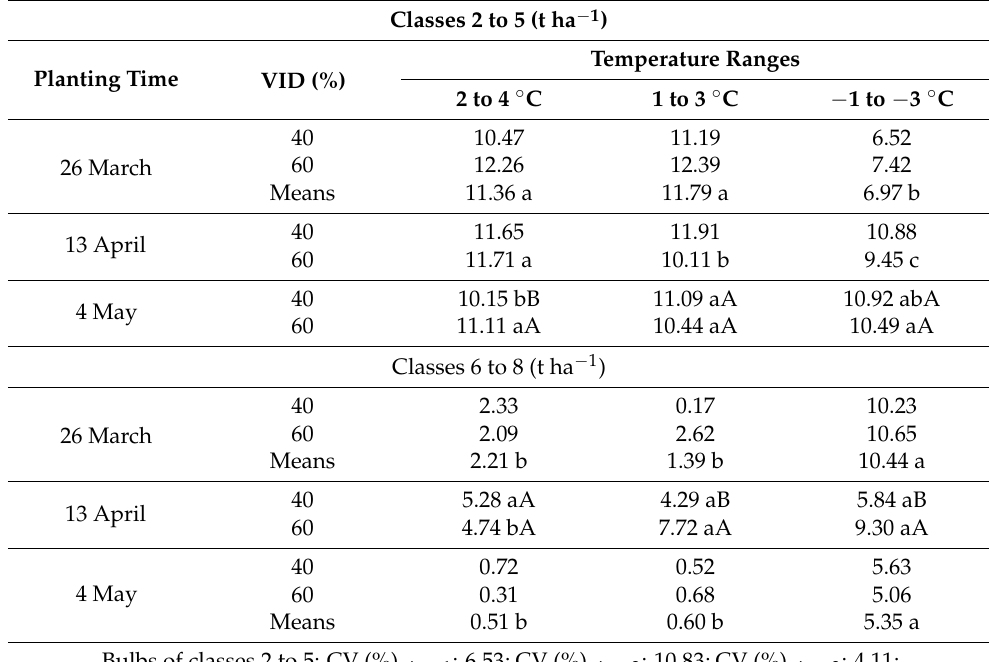
Table 9. Bulb productivity (t ha − 1 ) according to classifications 2 to 5 and 6 to 8, temperatures ranges, and visual index of overcoming dormancy